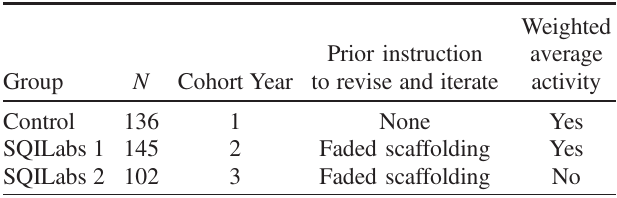
TABLE I. Summary of distinctive differences between the three conditions.